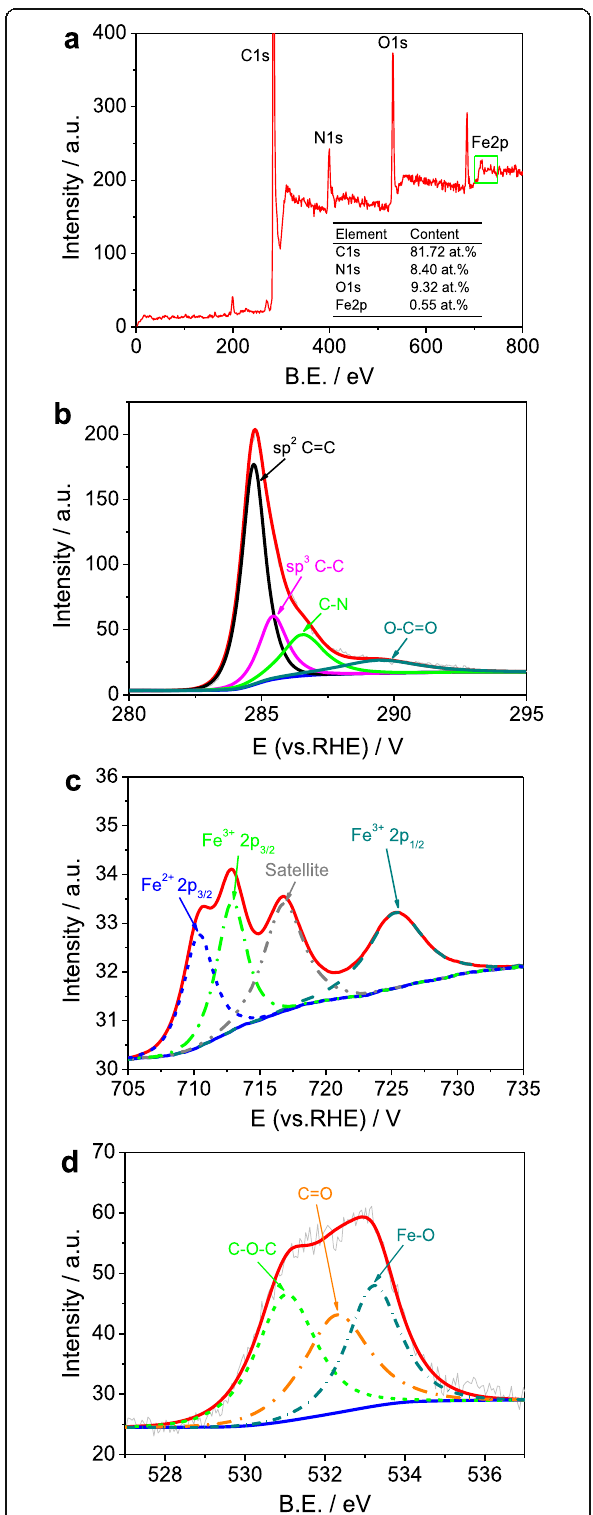
Fig. 4 Survey ( a ), Fe 2 p ( b ), O 1 s ( c ), and C 1 s ( d ) XPS spectra of m